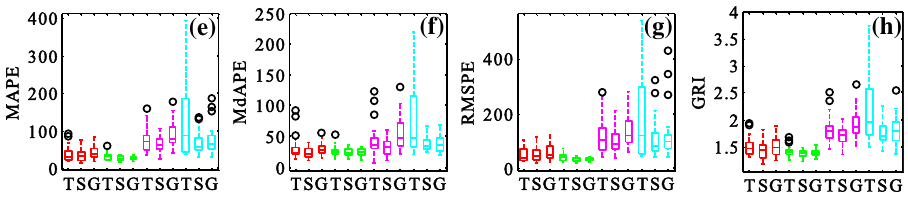
Fig. 14 The eight modeling accuracy indices for the seasonal precipitation (from left to right: spring, summer, autumn, and winter) during 2001–2010, using the time, seasonal, and global models